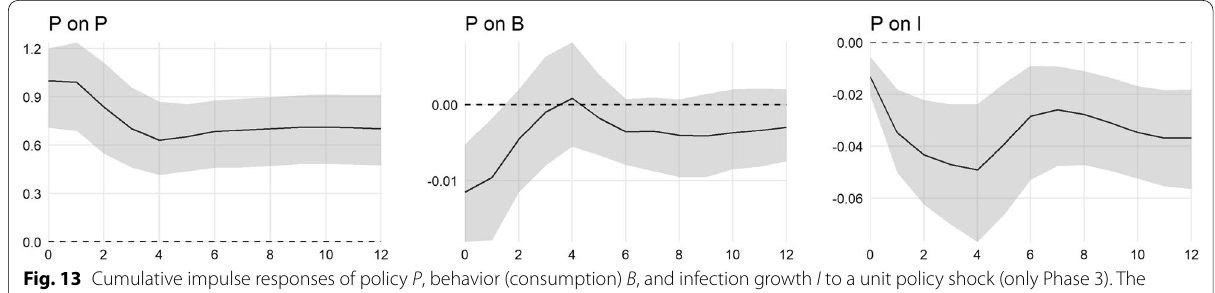
Fig. 13 Cumulative impulse responses of policy P , behavior (consumption) B , and infection growth I to a unit policy shock (only Phase 3). The impulse responses are estimated using the recursively ordered VAR(4) in (4) with k fixed effects. The data span September 28, 2020, until January 17, 2021. The shaded areas represent the 95% confidence intervals based on a wild bootstrap procedure with 5000 repetitions. The horizontal axes depict the time horizon in weeks. The vertical axes show the level response of the KSI + (left), lnNTRX (middle), lnNINF